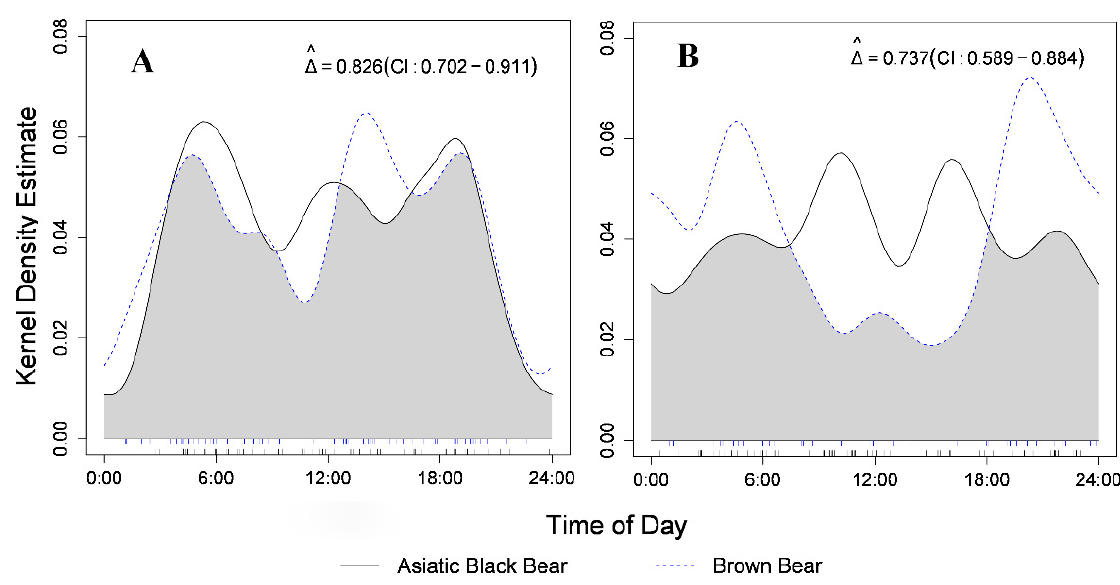
Figure 3. Daily activity patterns of Asiatic black bear and brown bear based on single–species detection ( A ) and co–detection ( B ) in Taipinggou National Nature Reserve, Heilongjiang Province, China, 2017. The mean value of the coefficient of overlap ˆ ∆ is represented by the light grey area under